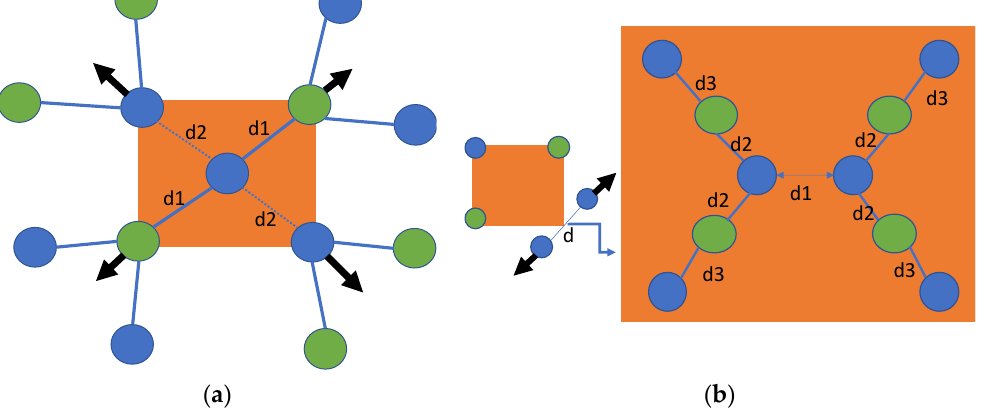
Figure 2. Final stable configuration of ( a ) base and ( b ) split <110> interstitials in alkali halides. Blue and green atoms are halogens and alkali metals, respectively. Arrows represent the direction of motion and their magnitude represents relative displacements corresponding to nearest neighboring atoms.